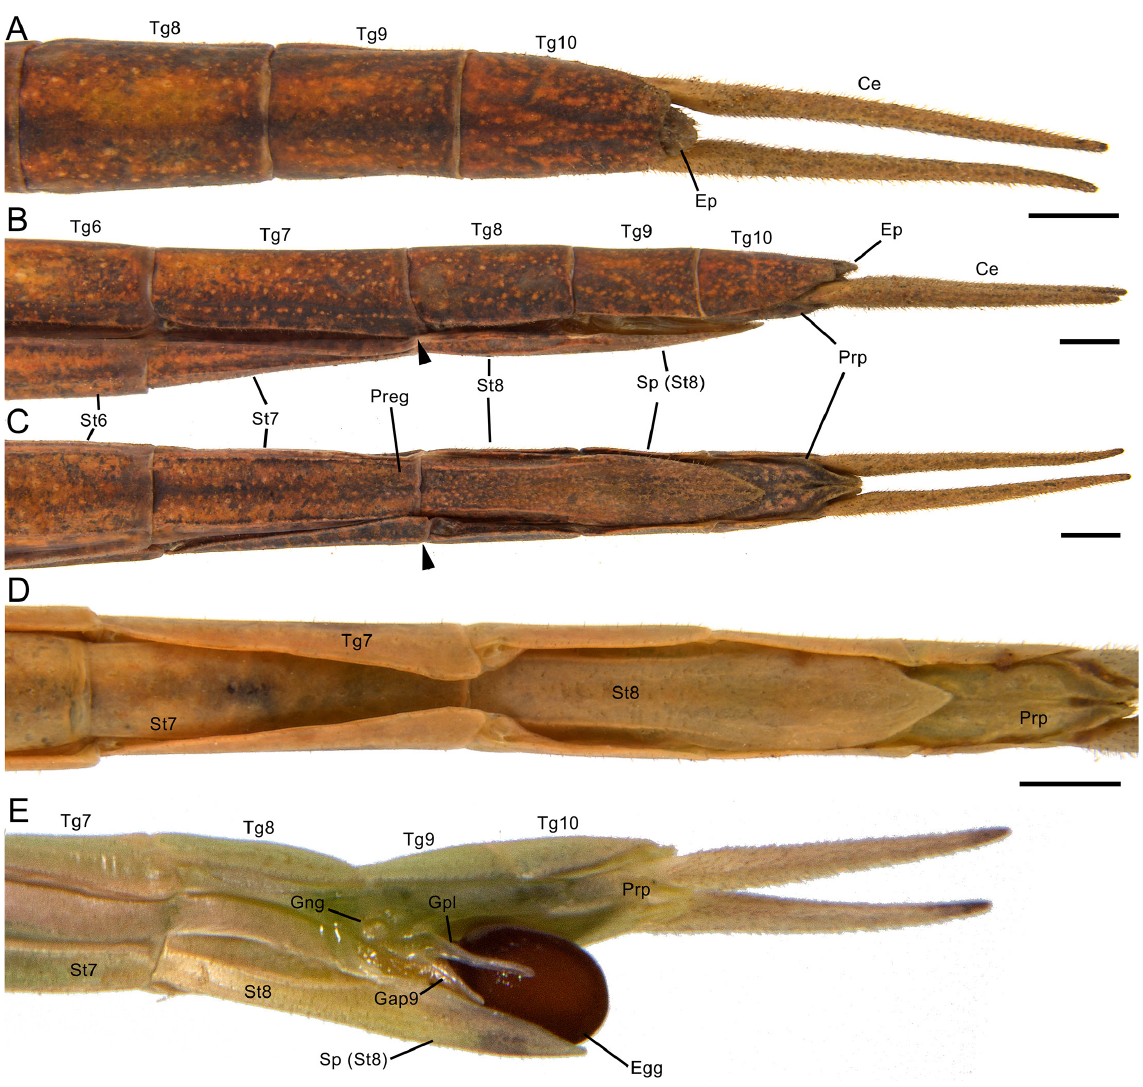
Fig. 7. Terminalia morphology of Arumatia dubia (Caudell, 1904) gen. et comb. nov. A–C . Adult